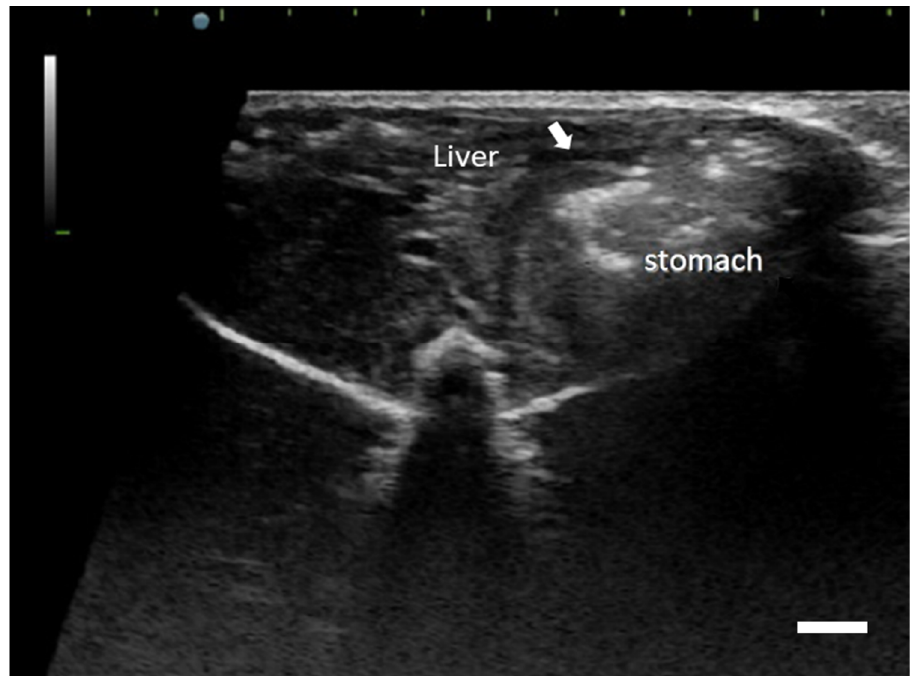
Figure 1. Gastric mast cell tumor, African dormouse. Transverse abdominal ultrasound image reveals focal, hypoechoic thickened foci of the gastric mucosa (arrow). Scale bar = 0.2 cm.